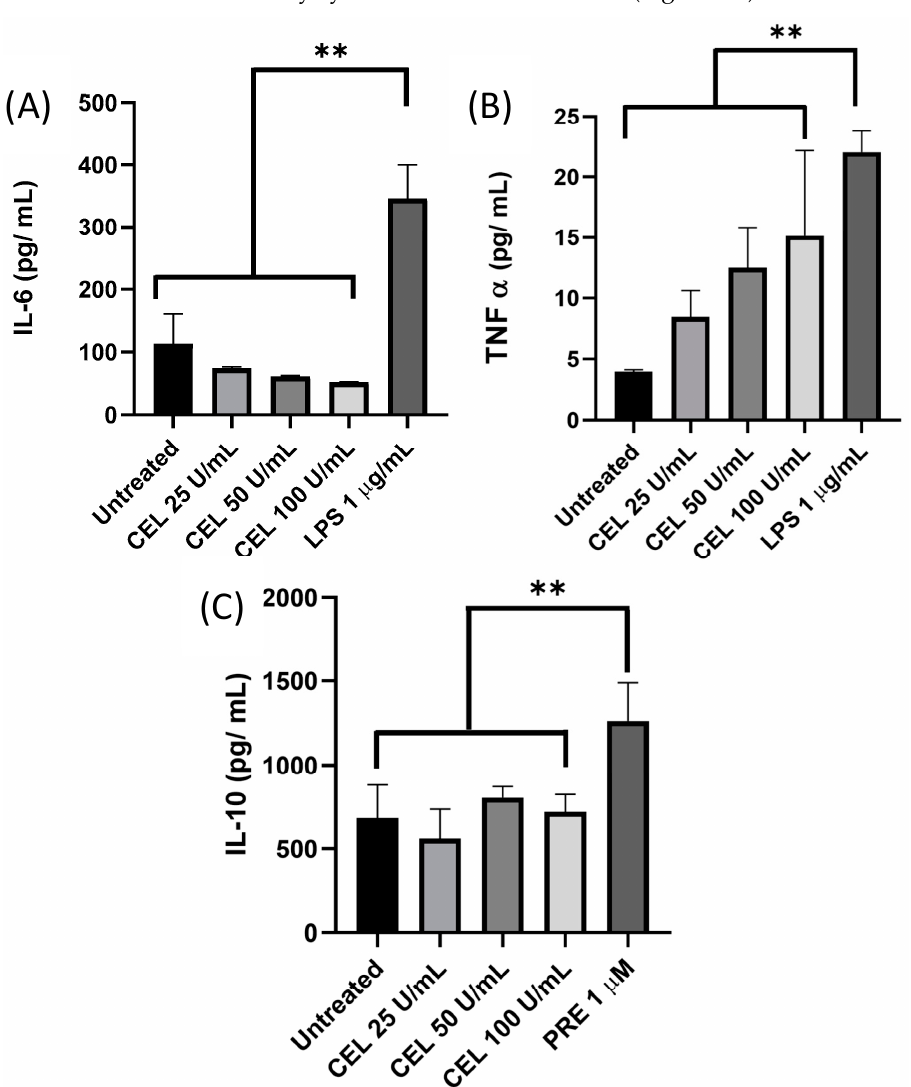
Figure 5. Inflammatory response of CEL. The inflammatory response of CEL was assessed using the THP-1 cell line using ELISA. ( A ) IL-6, ( B ) TNF- α , and ( C ) IL-10. CEL, cellulase; LPS, lipopolysaccha- ride (positive control); PRE, prednisolone (positive control). Data are shown as the mean ± SD of three independent experiments. ** p -value < 0.001.